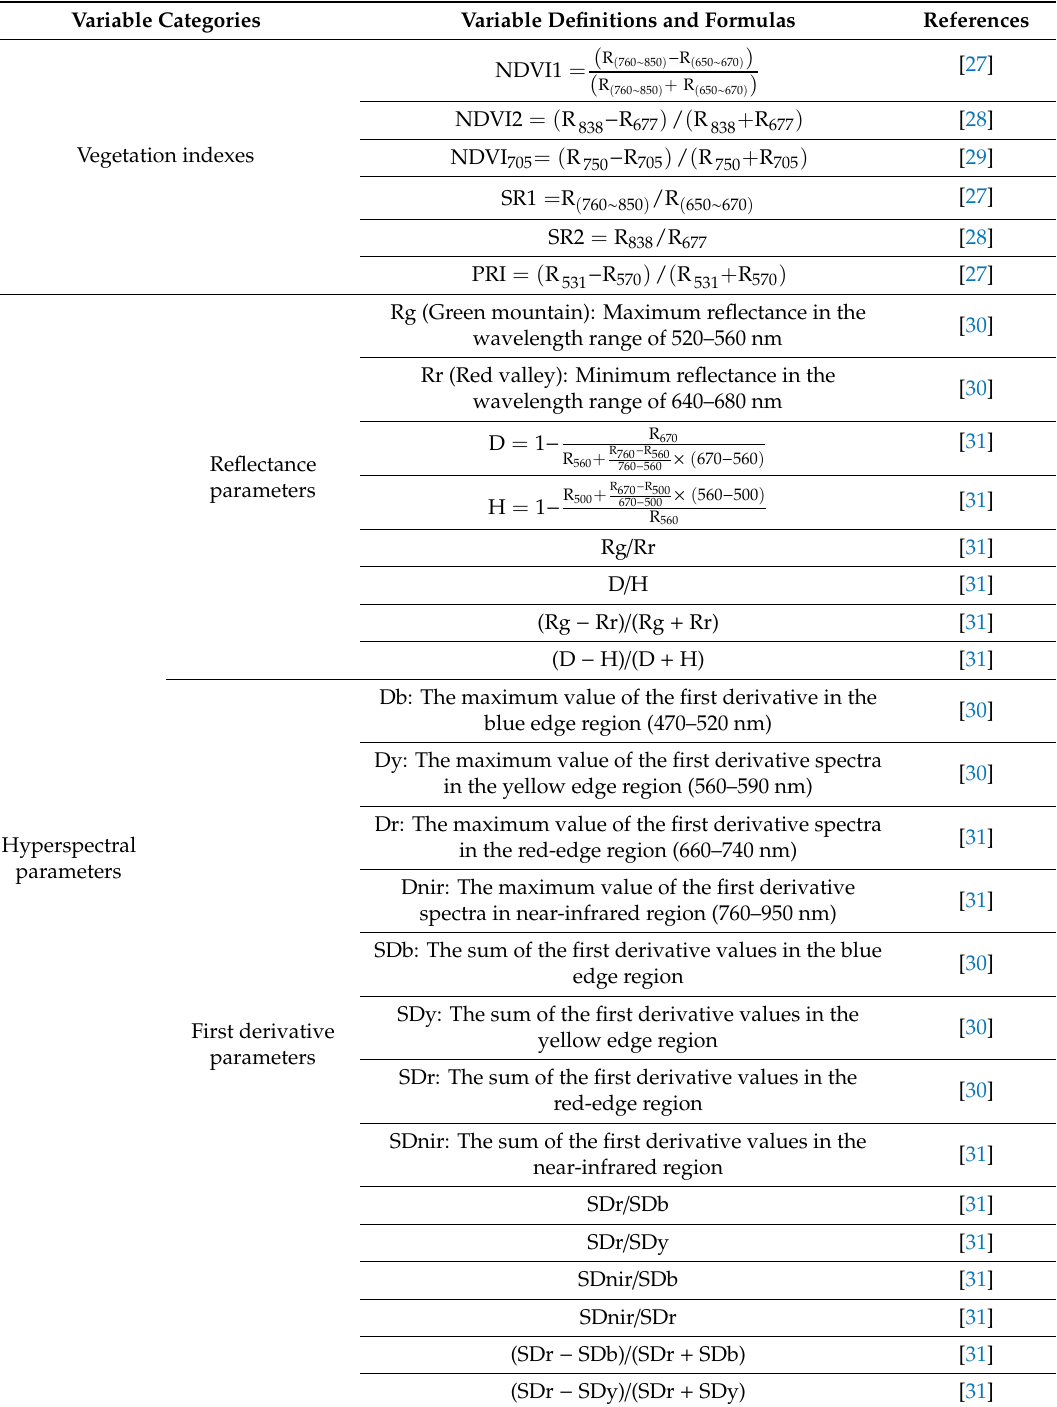
Table 3. Spectral parameters. Two types of spectral parameters were used in this study: vegetation indices and hyperspectral parameters. We also list specific calculation formulas and describe specific meanings. NormalizedDi ff erenceVegetationIndex(NDVI);RedEdgeNormalizedDi ff